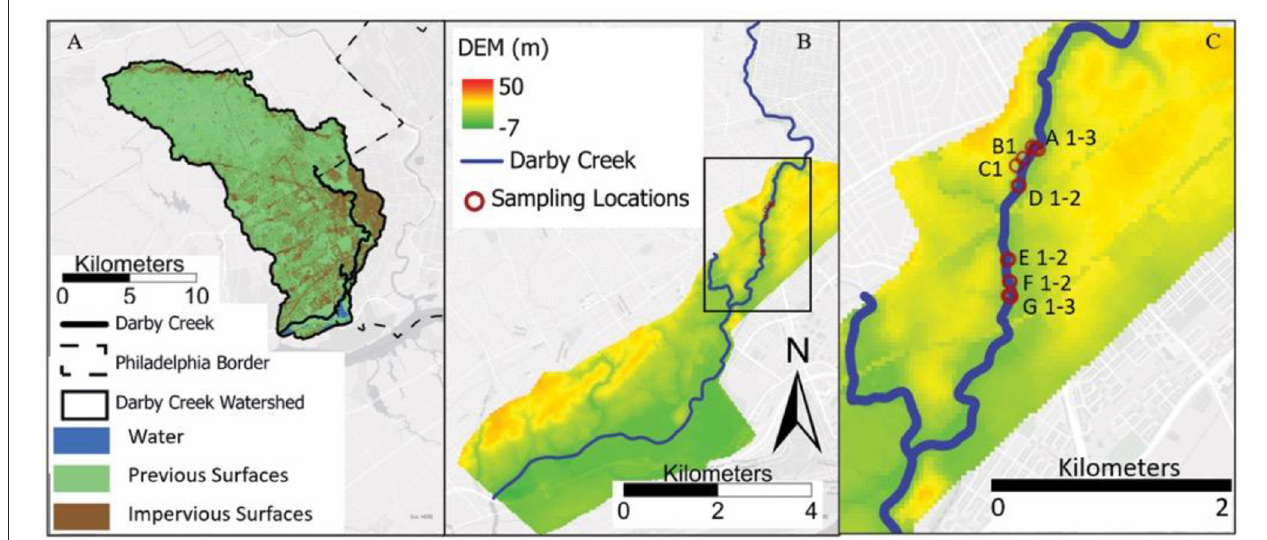
FIGURE 1 | (A) Darby Creek watershed adjacent to the Philadelphia border. (B) Digital elevation model (DEM) of the study area. The black box shows the boundary of image (C) . (C) A zoomed in image of the sampling